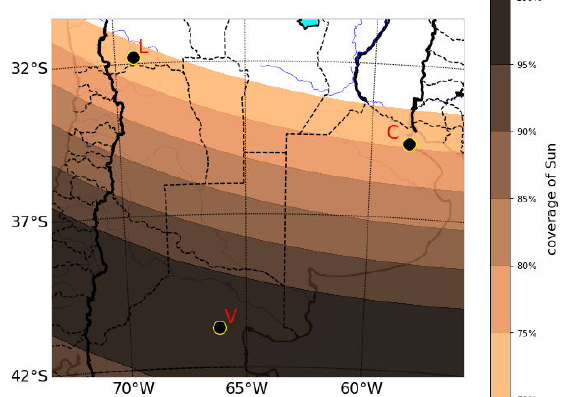
Figure 1: Path of the total solar eclipse of 14 Decem- ber 2020. Also shown are the locations of the three stations where PG was measured: CASLEO(L), CIT- EDEF(C) and Valcheta(V). The colours correspond to the percentage of